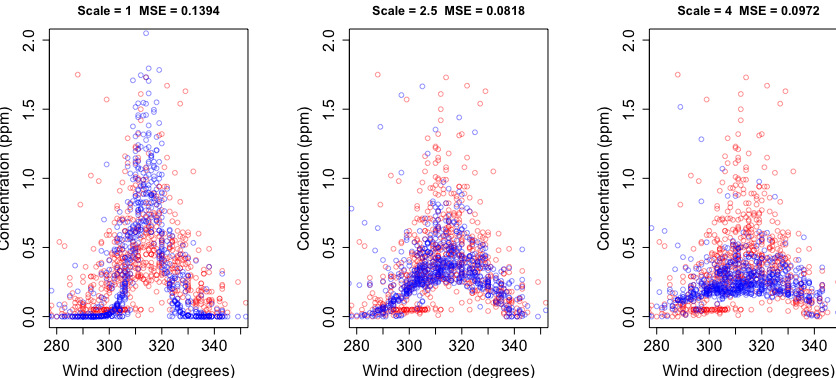
Figure 2. Predicted (blue) and observed (red) enhancements in parts per million (ppm) at EC.A between 21 May and 7 June 2015 when scaling σ y by 1, 2.5, and 4, respectively. The mean-squared errors (MSE) between the observed and the predicted enhancements are also i ,k i shown. Of the three, the best agreement between predicted and observed values occurs when σ y